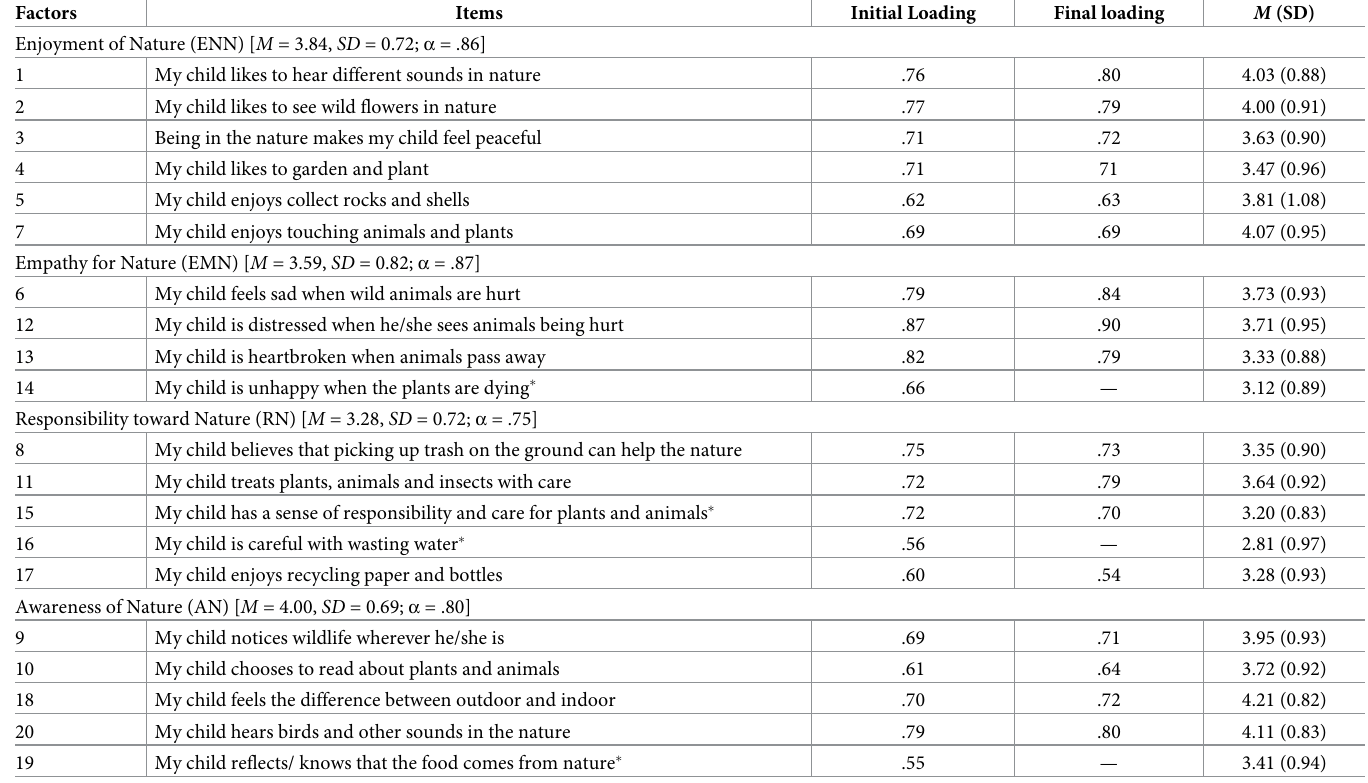
Table 1. Connectedness to nature index—parents of preschool children (CNI-PPC) items and factor descriptive